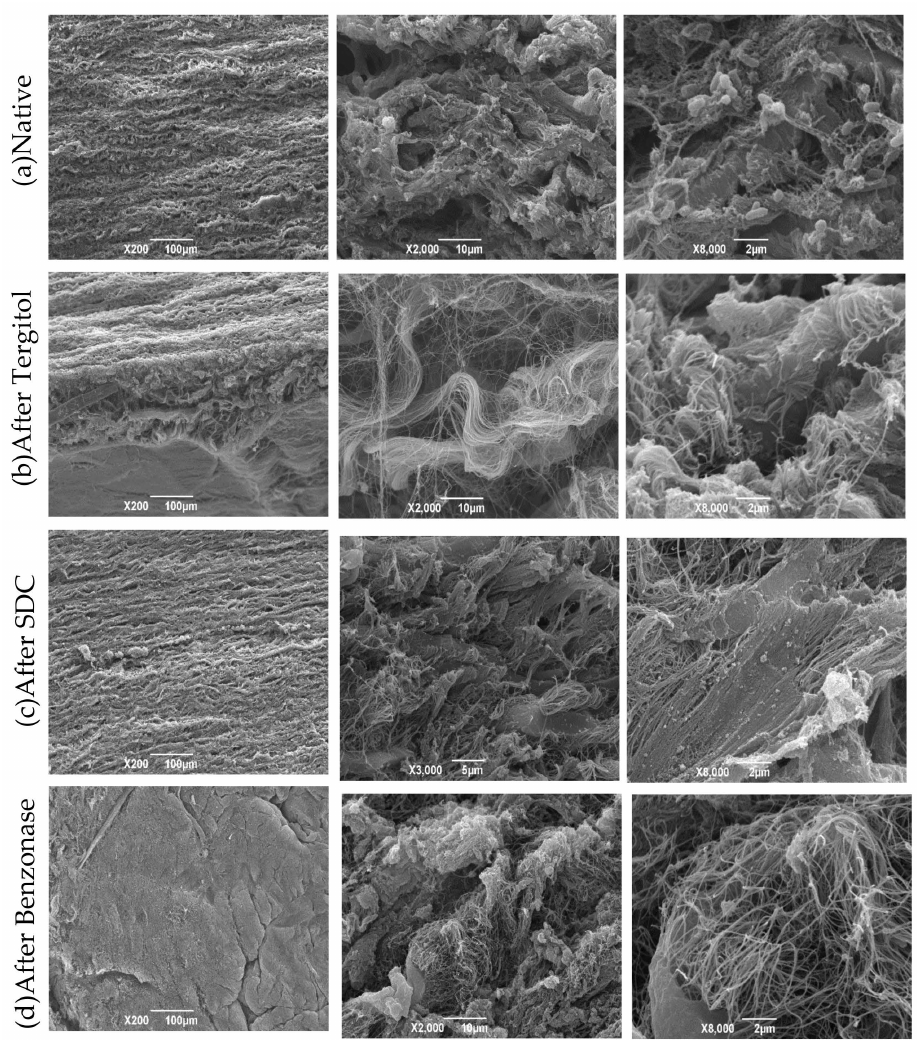
Figure 7. SEM images represent the gradual changes in morphological features of the native aortic wall tissue ( a ) and along the sequential steps of decellularization ( b – d